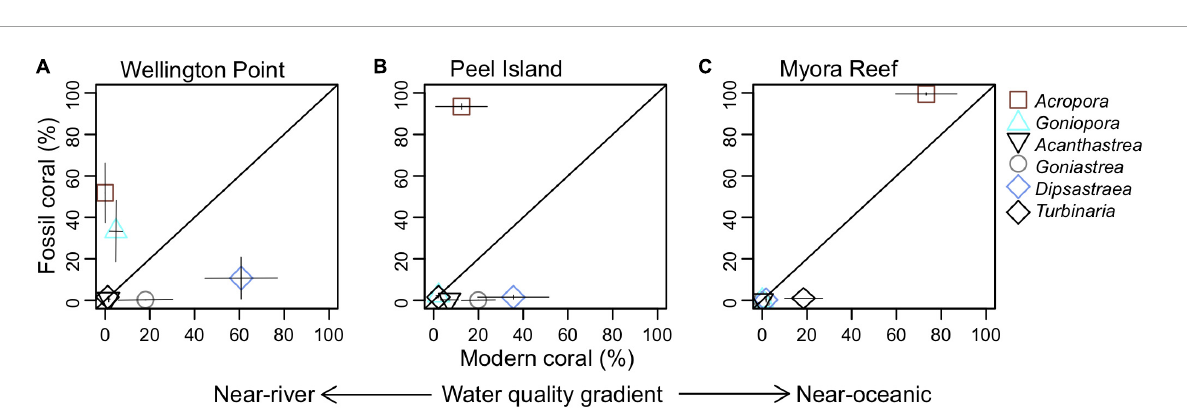
FIGURE5 Relative abundance (percent ± SE) for most common coral genera from: (A) Wellington Point, (B) Peel Island, and (C) Myora Reef in modern versus fossil assemblages from Moreton Bay. Each symbol represents pooled transects or cores from each site. Diagonal line represents equal contribution for modern versus fossil